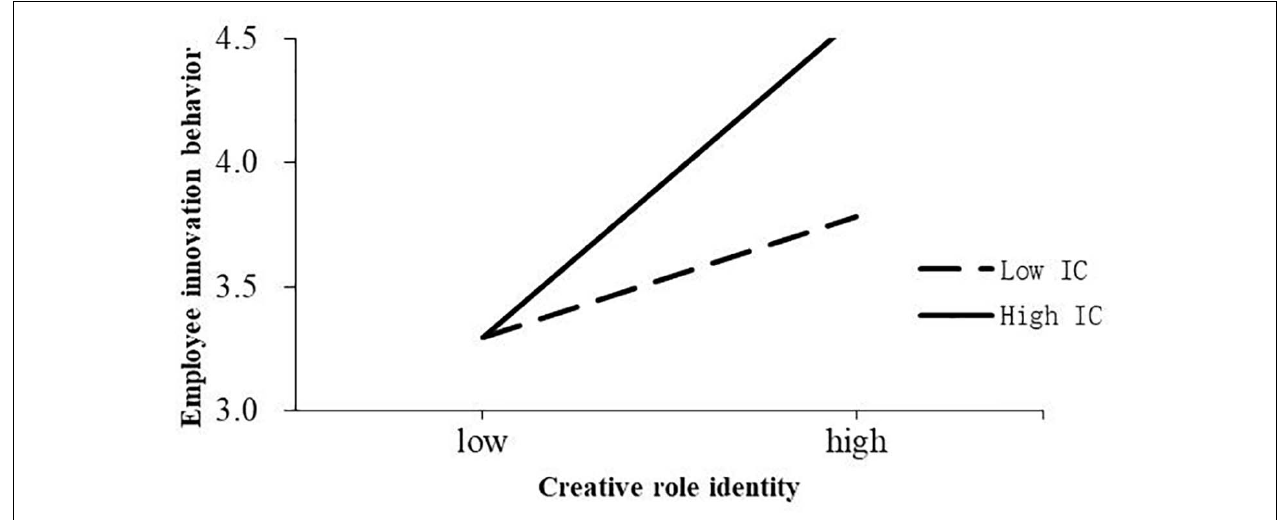
FIGURE 2 | Interactive effects of creative role identity and innovation climate on